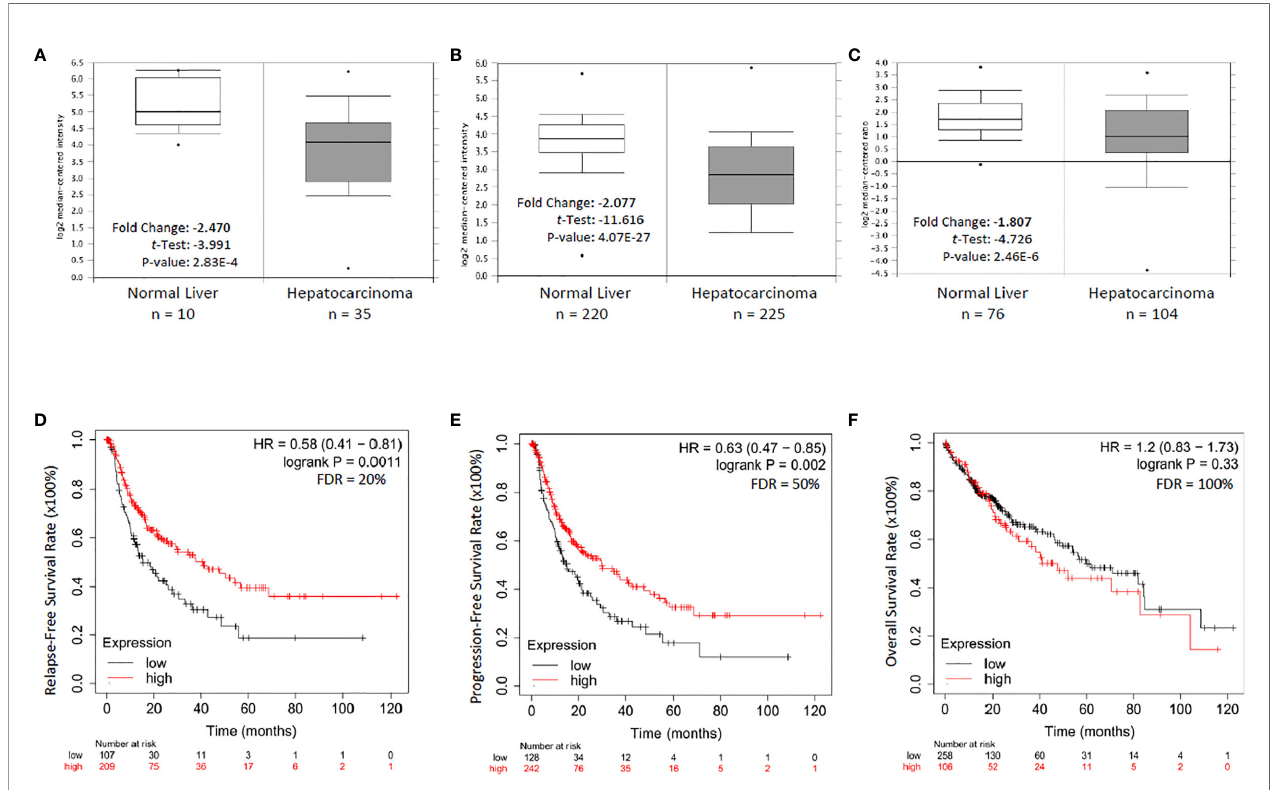
FIGURE 2 | NR0B2 expression is signi fi cantly reduced and associated with recurrent-free and progression-free survival in liver cancer patients. (A – C) NR0B2 expression data were queried from three representative datasets in the Oncomine ™ database; A-Wurmbach (24), B-Roessler (25), and C-Chen (26). Statistical information is inserted in the plot, and the case numbers for each group were listed below the plot. (D – F) . The Kaplan Meier plotter was used to assess the effect of NR0B2 gene expression (RNAseq data for the mRNA level) on liver cancer patients ’ survival status (n = 364). The data sources for the analysis include GEO, EGA, and TCGA. The prognostic value of NR0B2 gene expression levels was compared by splitting the patient cohort into two groups according to the quantile expressions of the NR0B2 gene. The Kaplan-Meier survival plot was used to calculate the hazard ratio with 95% con fi dence intervals and log-rank p